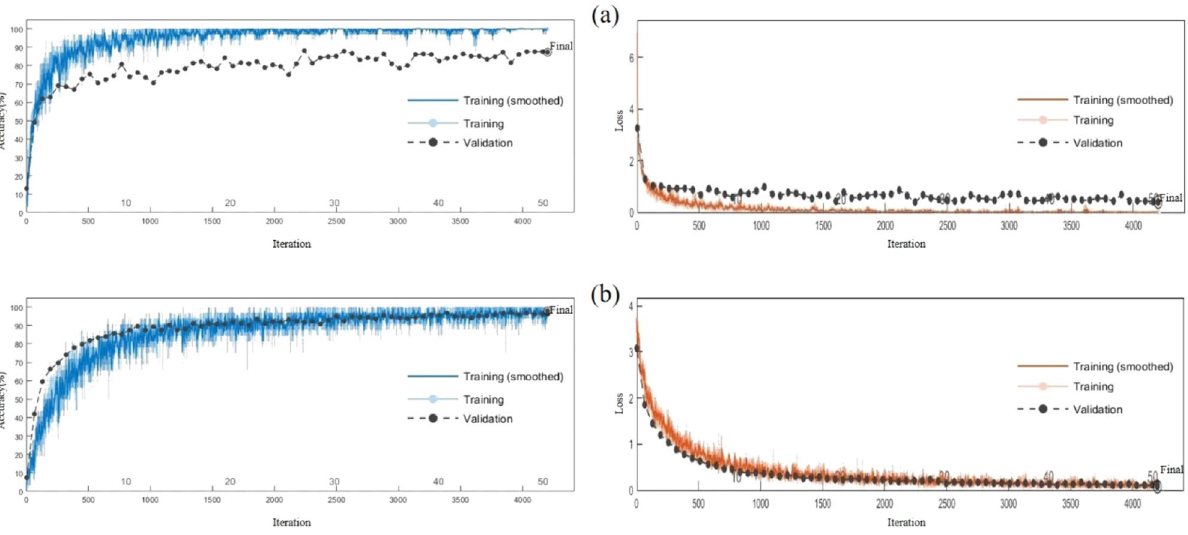
Figure 6. Model training result